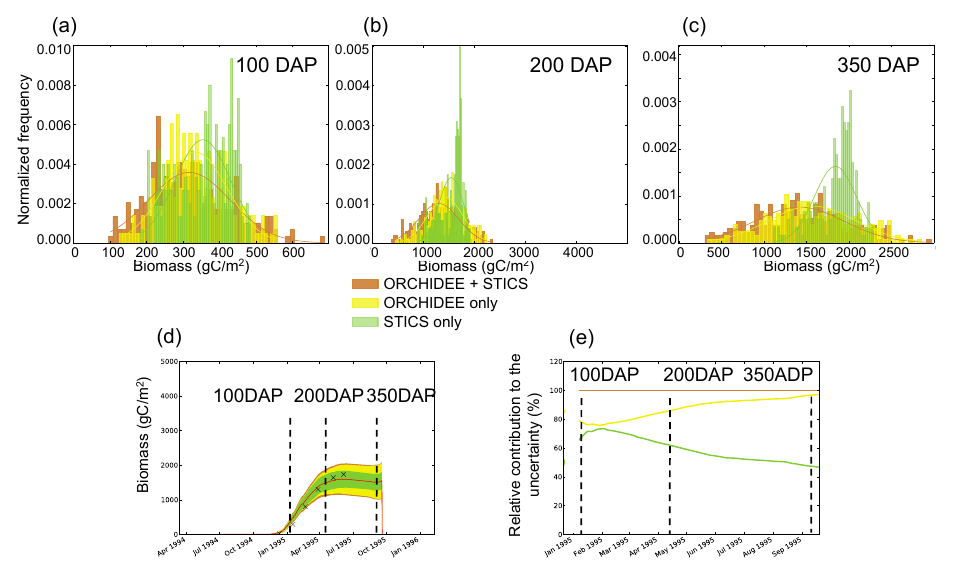
Figure 6. Uncertainty analysis for the site Grafton 94–95. (a–c) Probability distributions of harvested biomass simulated after parameter uncertainty (from STICS: green, from ORCHIDEE: yellow, from ORCHIDEE + STICS: brown) has been propagated into the model. (d) Reference simulation of harvested biomass (red) and uncertainty from ORCHIDEE, STICS, ORCHIDEE + STICS. (e) Contribution (%) of ORCHIDEE (yellow) and STICS (green) to the total uncertainty (brown) over the length of the growing